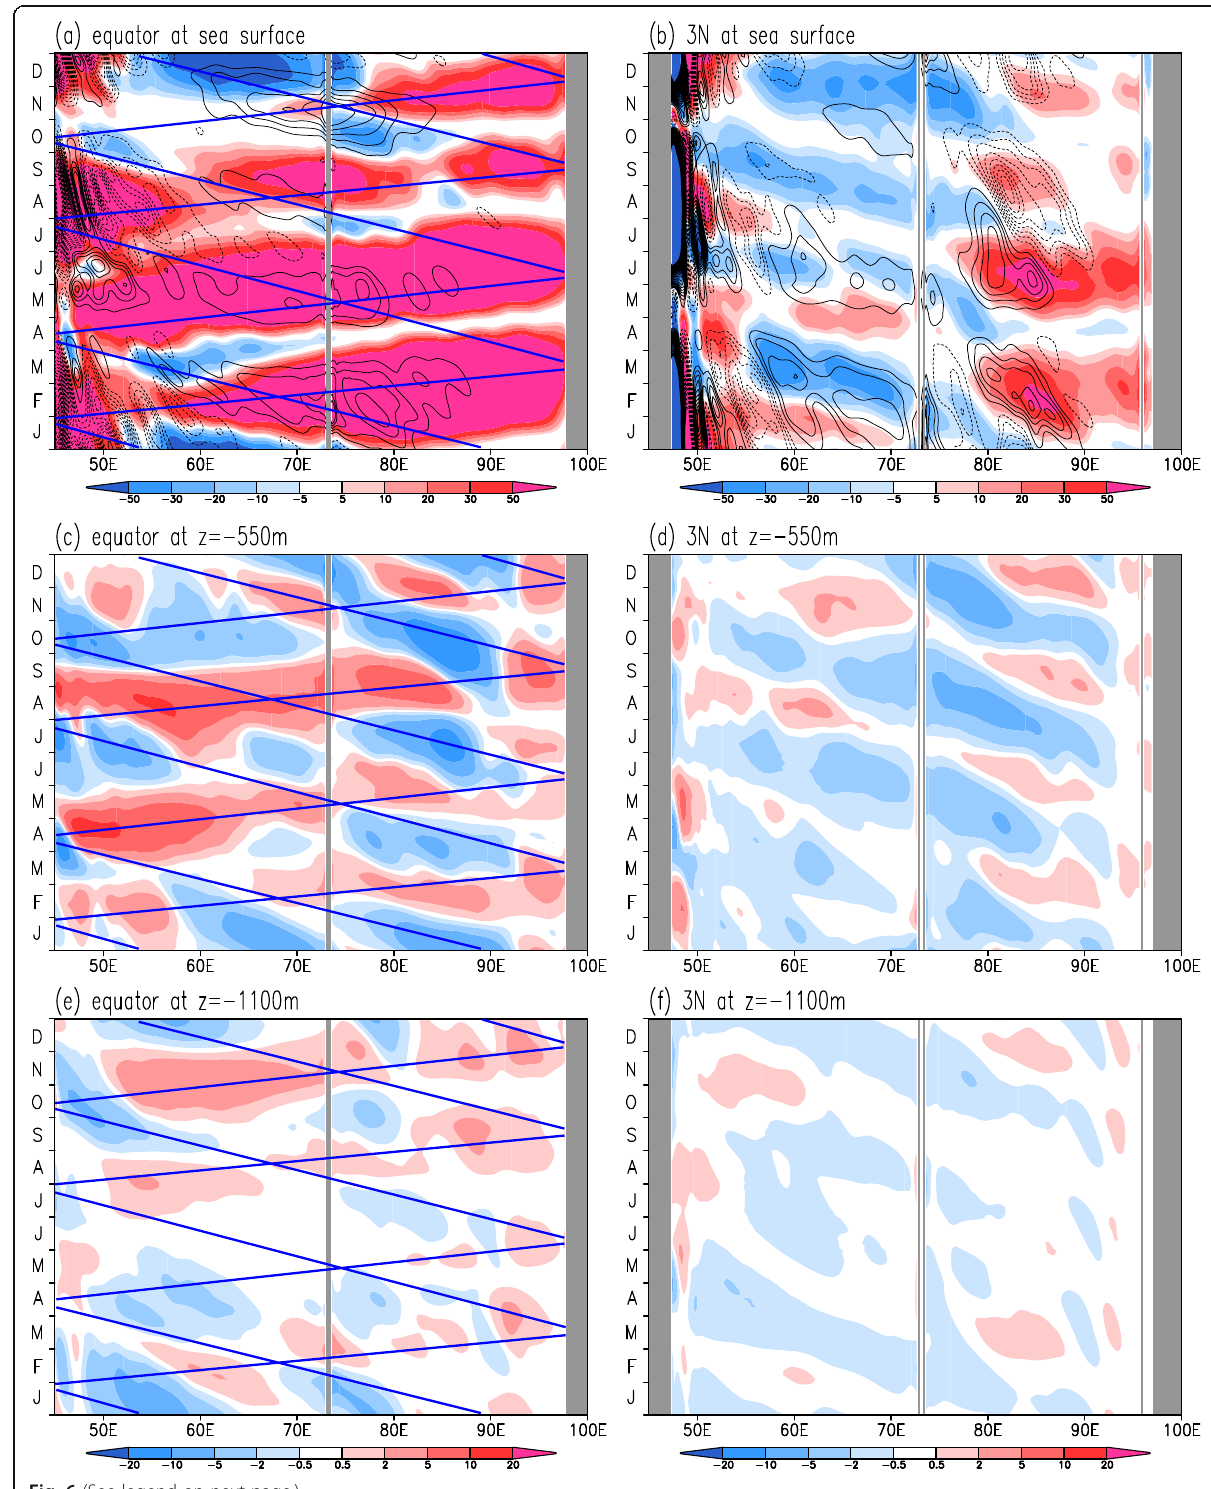
Fig. 6 (See legend on next